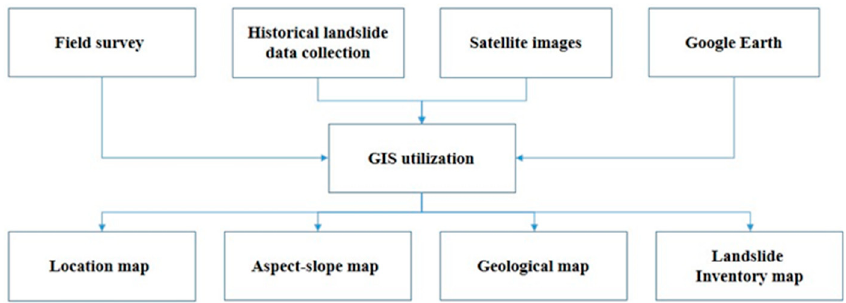
Figure 4. The methodology of the study area.